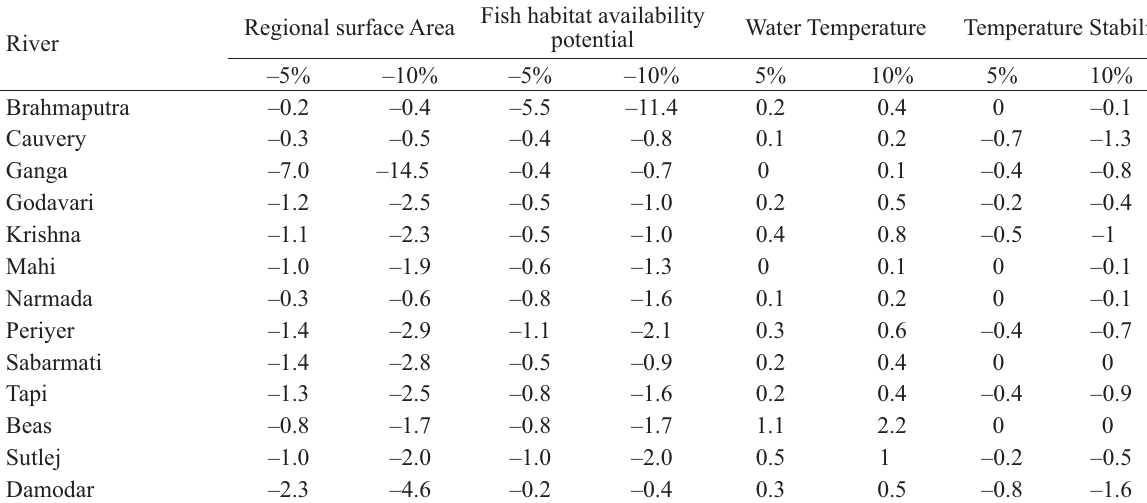
Predictive changes (percentage point) of fish species richness in different rivers due to change (percentage point) in individual factor scores